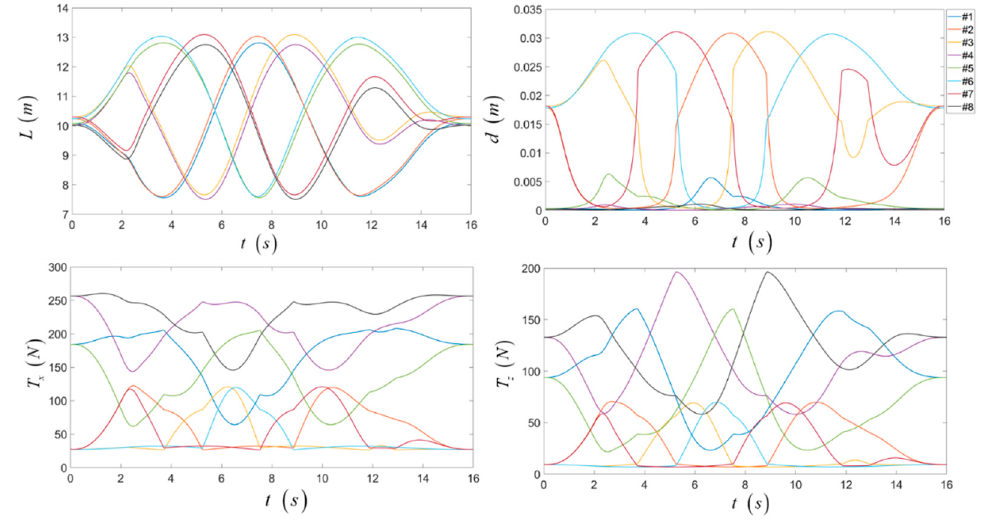
Figure 20. Unstrained length L , adjusting length d , tension along X -axis T x and tension along Z -axis T z Figure 20. unstrained length L , adjusting length d , tension along X -axis respect to { A } of CDPM that has the first configuration during the simulation { } A of CDPM that has the first configuration during the simulation test. T respect to axis z